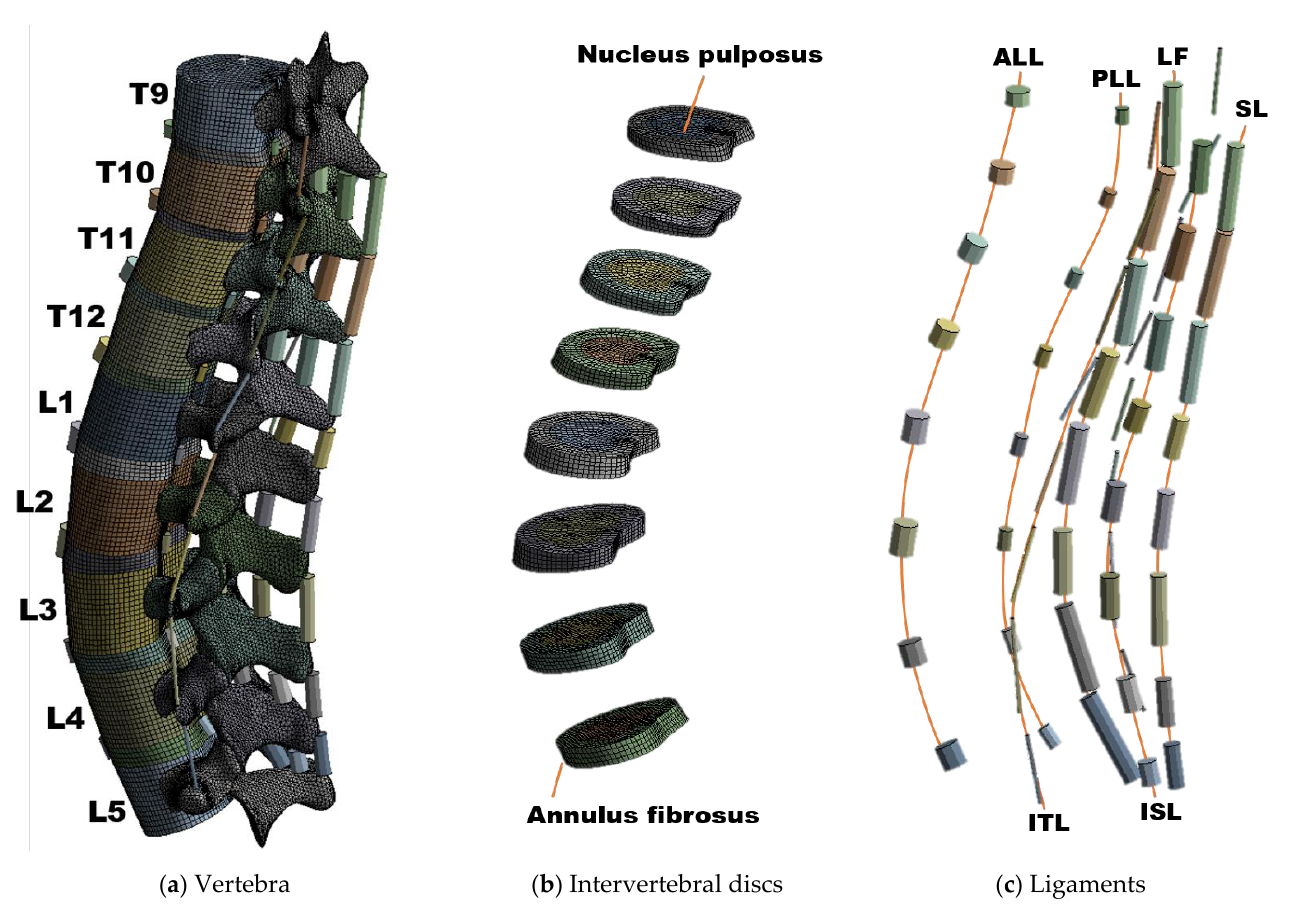
Figure 1. Composition of the human spine finite element (FE) model: ( a ) Overall shape of the intact FE model, ( b ) FE model of an intervertebral disc composed of nucleus pulposus and annulus fibrosus, and ( c ) six major ligaments of the spine; 2-node link element.